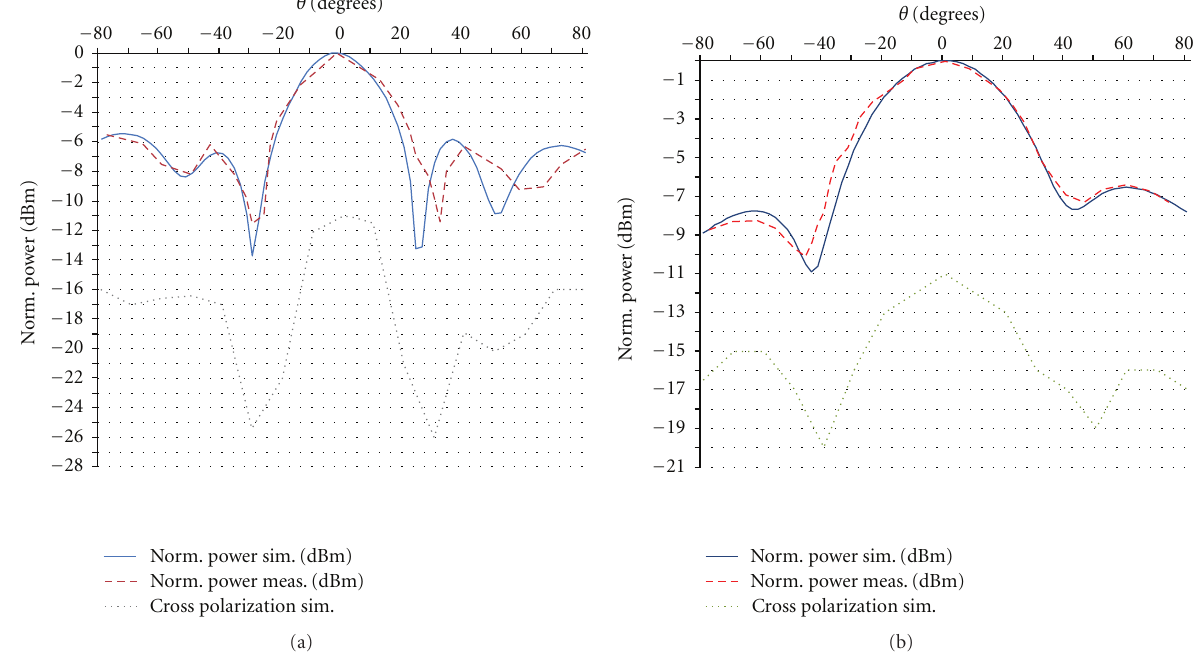
Figure 4: (a) Radiation pattern of access antenna in yz plane for 3.5GHz. (b) Radiation pattern of access antenna in xz plane for 3.5GHz.